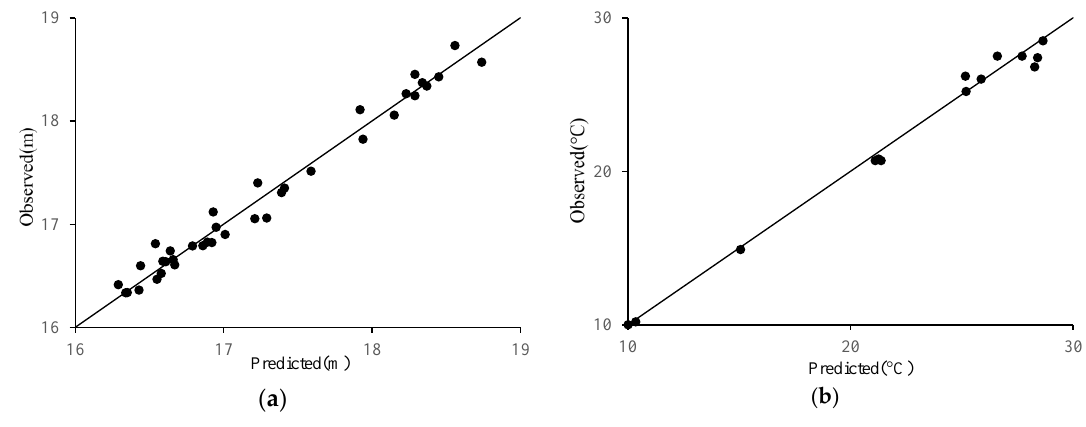
Figure 3. Validation of water-surface elevations ( a ) and water temperature ( b ).